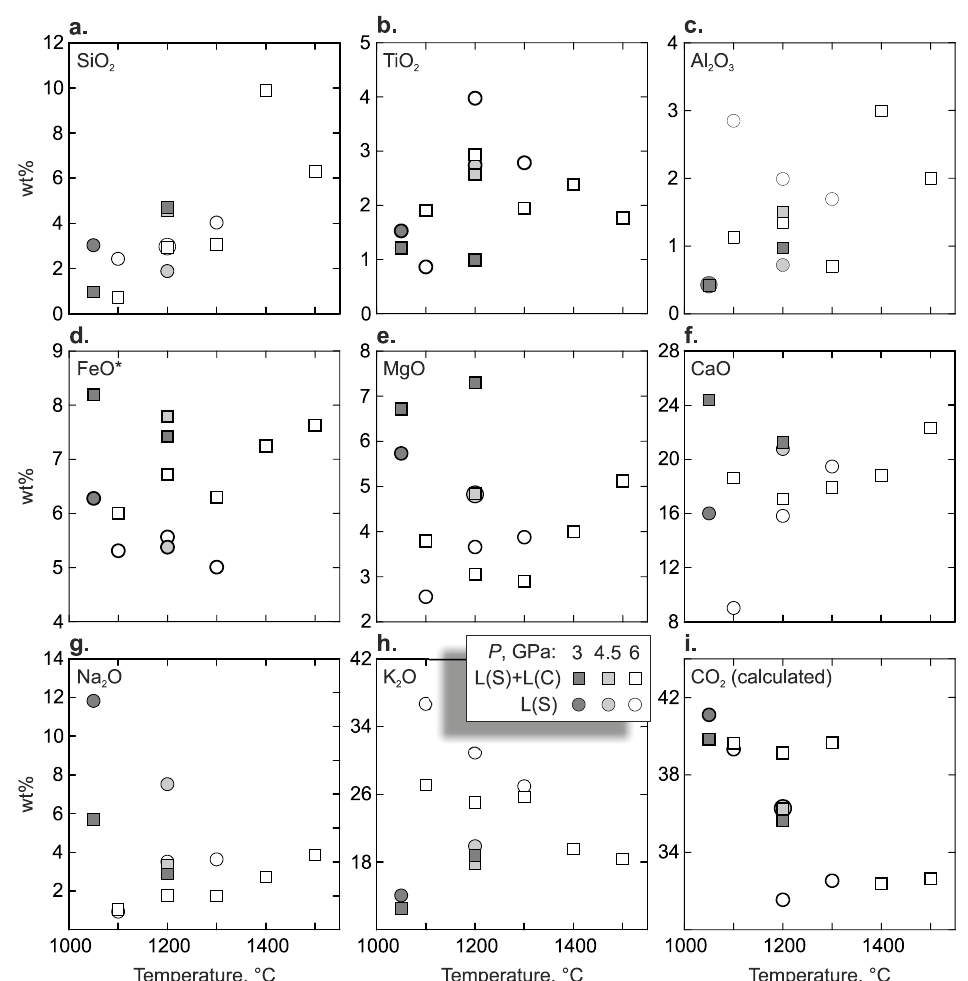
Figure 12. Compositions of carbonate melt as a function of temperature. ( a ) SiO 2 , ( b ) TiO 2 , ( c ) Al 2 O 3 ,